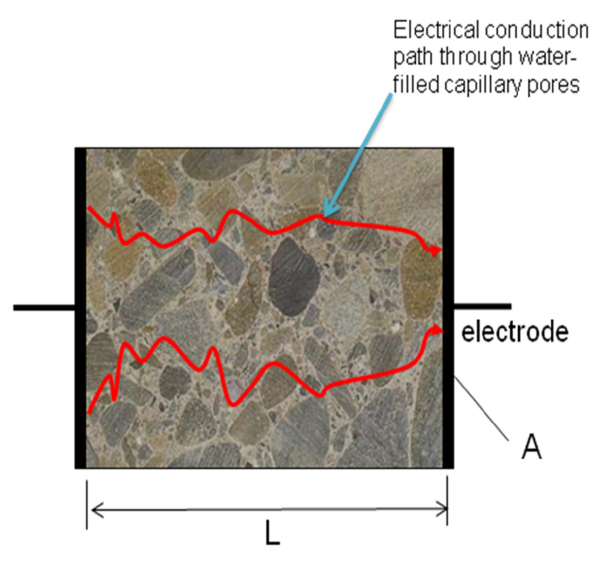
ff ect of pore water on the electrical resistivity of concrete. Figure 6. Effect of pore water on the electrical resistivity of concrete. Figure 6. E